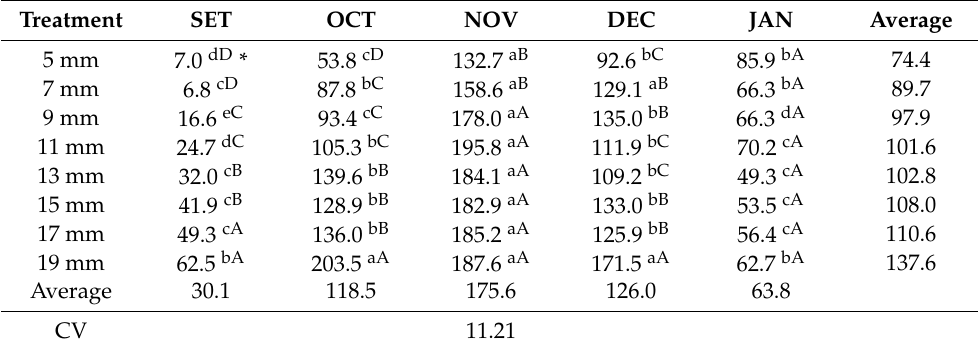
Table 2. Productive seasonality of strawberry plants cv. ‘Pircinque’, from plants with different crown diameters, in the agricultural cycle of 2016/2017.